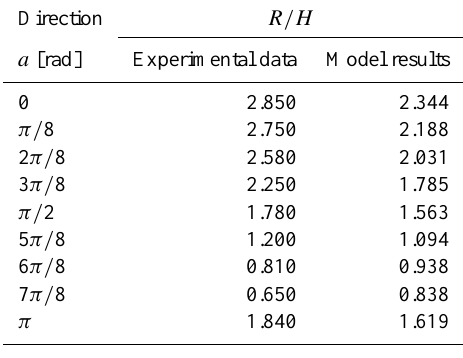
Table 1. Tsunami run-up on a circular island: comparison of the normalized maximum run-up height ( R/H) distribution around the island between model results and the measurements of Briggs et al. (1995) for ε = 0 . 10; the angle α = 0 corresponds to the front direction of the wave approaching the island and α = π to the back direction. Direction R/H a [rad] Experimental data Model results